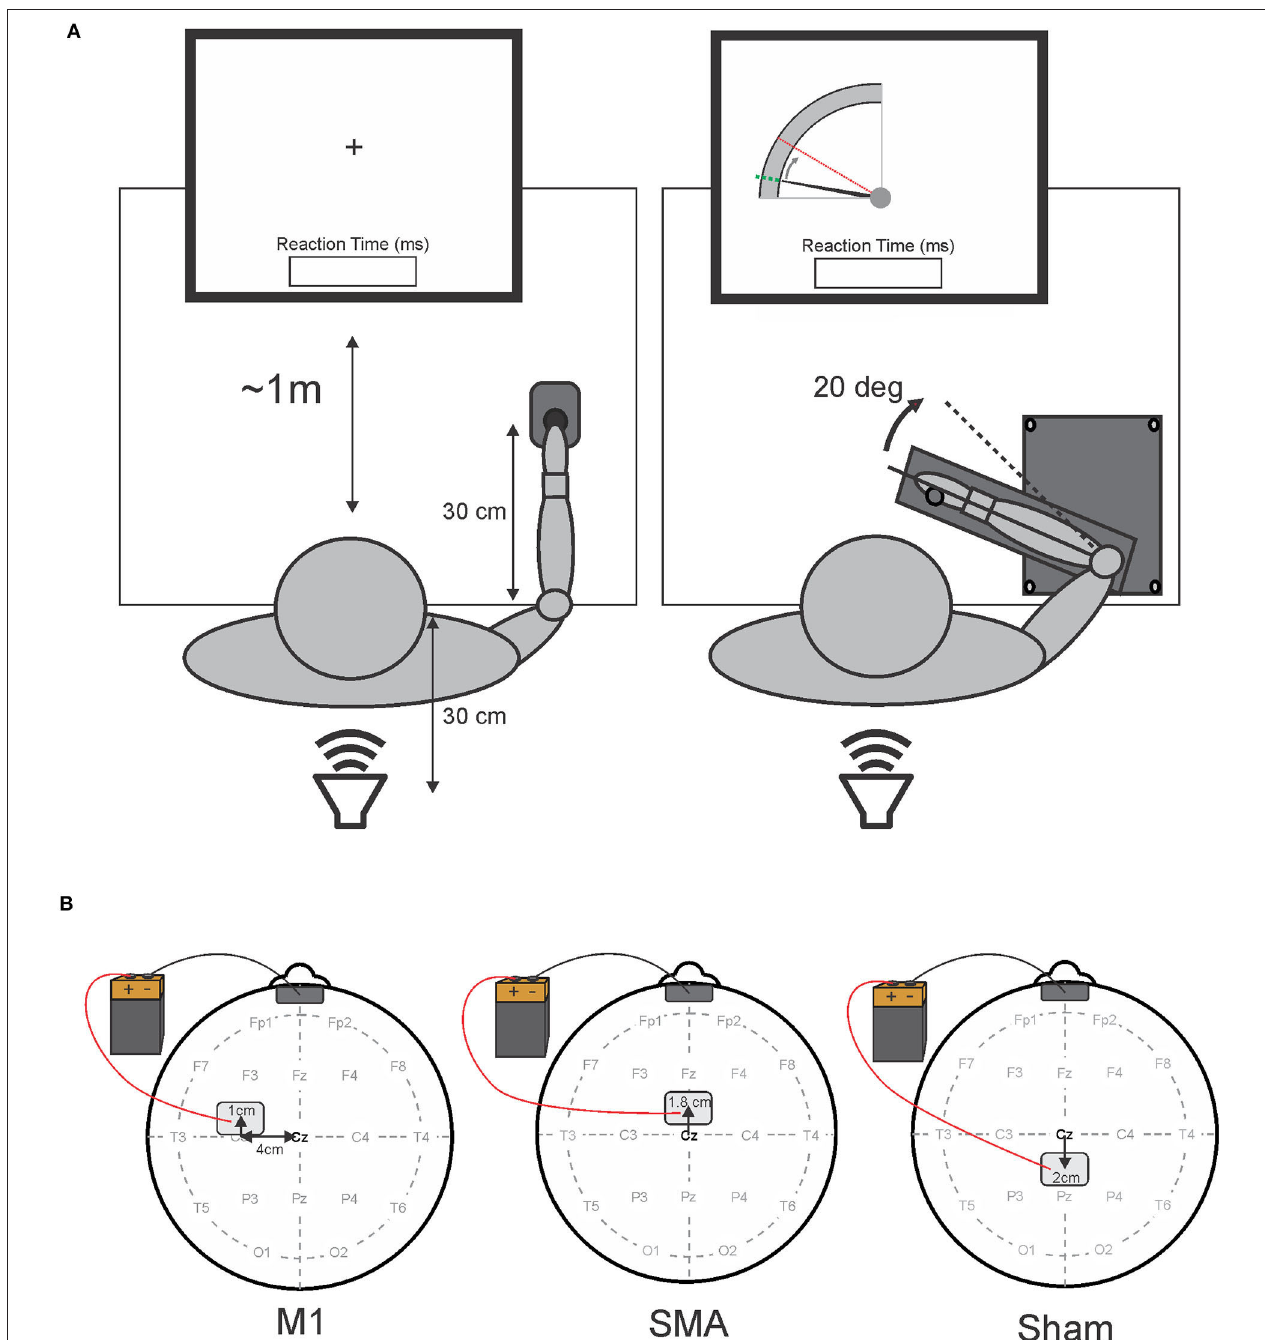
FIGURE 1 | Schematic representation of experimental tasks (A) and tDCS electrode placement (B) . (A) Shows a schematic overhead representation of the experimental apparatus and participant placement. The left side depicts the button-press task with the fixation cross, while the right side depicts the elbow-extension task, and the visual feedback on target accuracy presented to the participant at the beginning and the end of each trial for the elbow-extension task. The position of the elbow was represented by the solid black cursor moving from the home position (a dotted green line) to the 20 ◦ target (a dashed red line). In both tasks, reaction time feedback was displayed immediately following each trial. A loud speaker placed 30cm behind the participants delivered the auditory stimuli. Panel B depicts tDCS electrode placement for each session. The left side illustrates primary motor area (M1) stimulation (note: the anode electrode was placed over M1 contralateral to the limb used to perform the reaction time tasks); the center image illustrates supplementary motor area (SMA) stimulation; the right side illustrates sham stimulation. The cathode electrode was placed on the forehead (center, above the eyebrows) for all sessions.